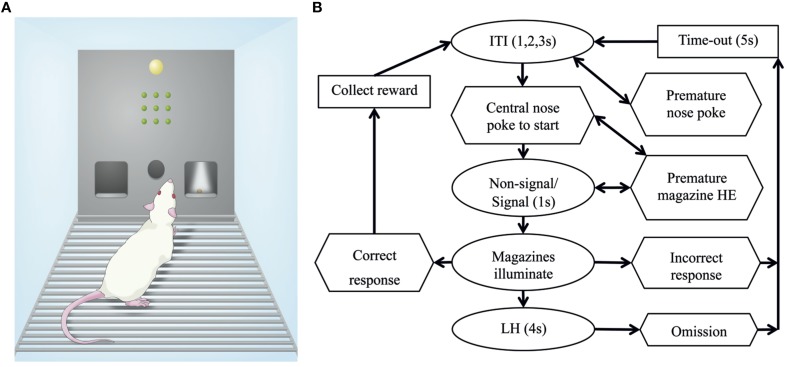
The Signal Detection Task. (A) Schematic of chamber arrangement including a house light, grid of lights for signal presentation, and central nose poke with a magazine on each side. (B) Trials started with a brief inter-trial interval (ITI) before the central nose poke aperture illuminates and the rat makes a nose poke response to begin the trial. Immediately upon nose poke detection, the signal was presented (or absent for non-signal trials) for 1 s. Following the signal presentation both the left and right magazines illuminated indicating the rat should make a choice. If the correct side was chosen a food reward was delivered, alternatively if the incorrect side was chosen there was a brief time out (5 s). If no response was made after a 4 s limited hold (LH) the trial ends with an omission scored. Nose pokes and head entries (HE) made at inappropriate times were recorded but not punished.